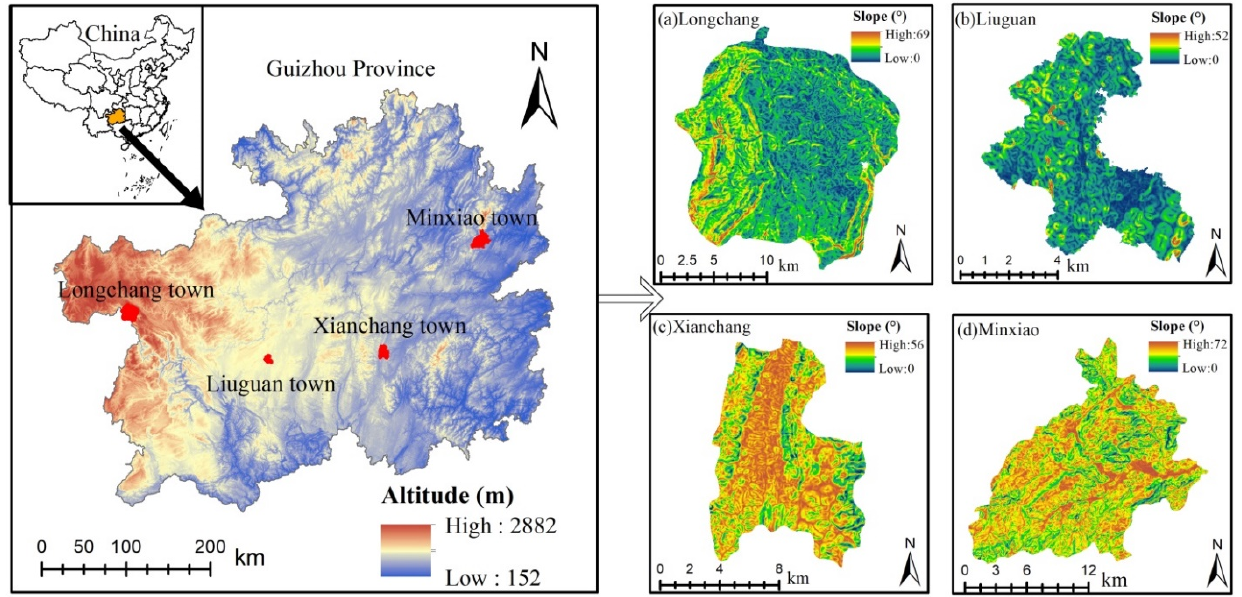
Figure 1. The locations of the four selected towns in karst mountainous areas. ( a ) Longchang, ( b ) Liuguan, ( c ) Xianchang, ( d )